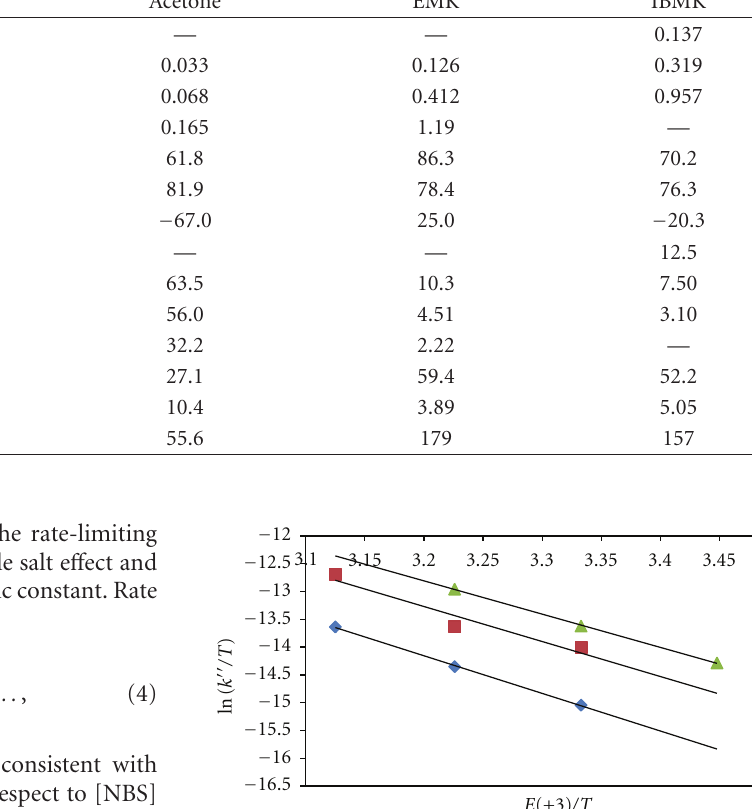
Table 6: Kinetic and thermodynamic parameters involving rate constants and formation constants for Ru (III) catalyzed system. Parameter